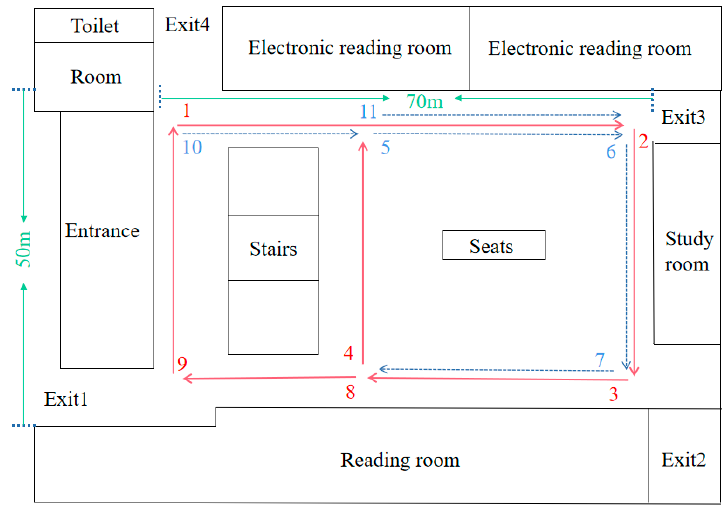
Figure 9. Hall on the second floor of the library.